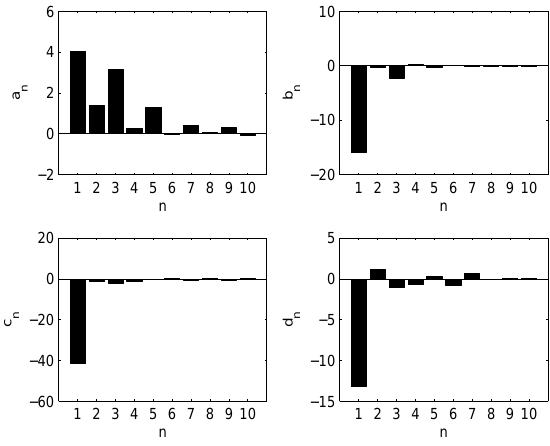
Figure 8. Elliptic Fourier function coefficients describing the deposit contour observed in experiment no.